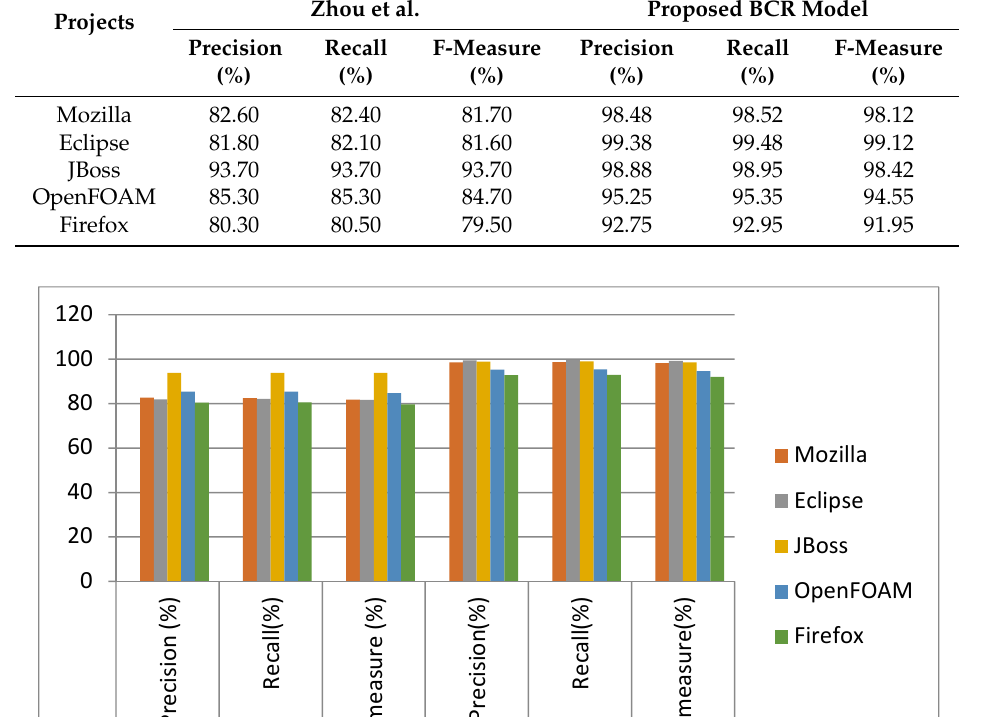
Table 5. Comparison of results of five projects based on binary classification.